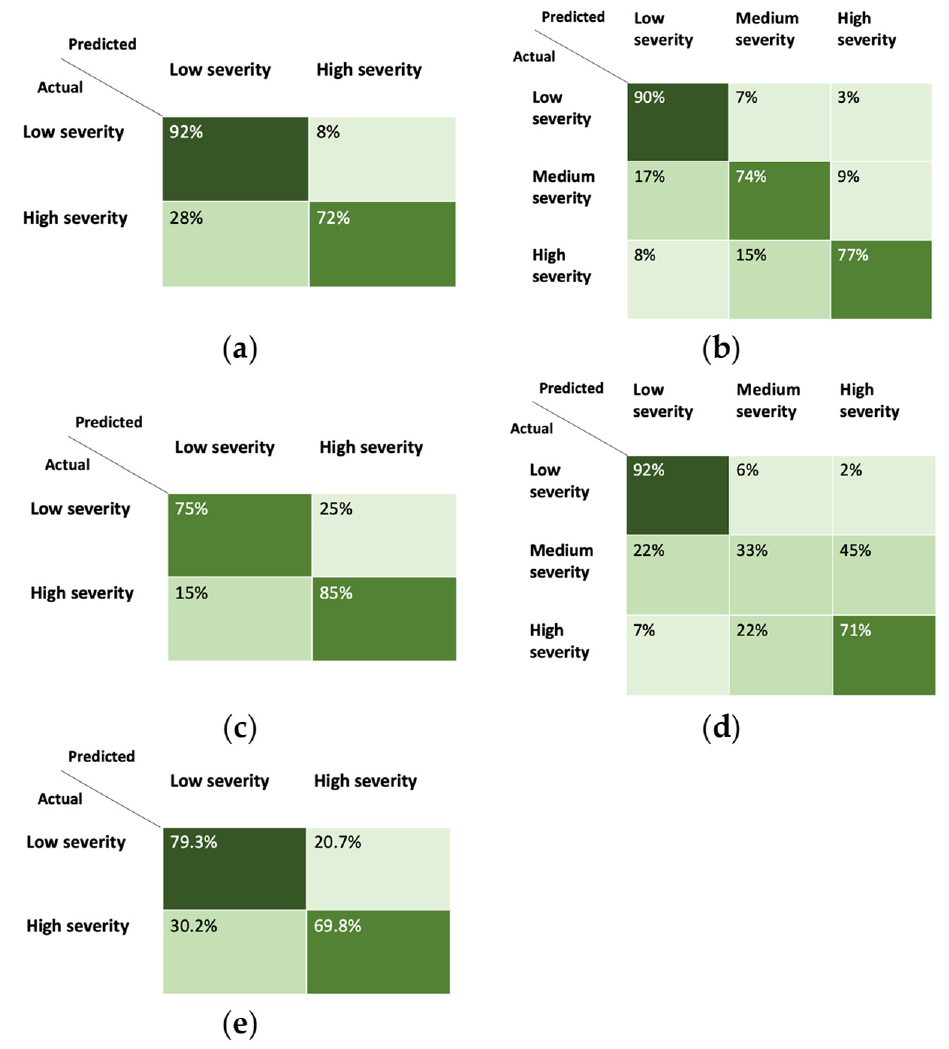
Figure 3. Confusion matrix (measured on the validation dataset): ( a ) MLP Model A, ( b ) MLP Model B, ( c ) RF Model A, ( d ) RF Model B, and ( e ) binary regression.